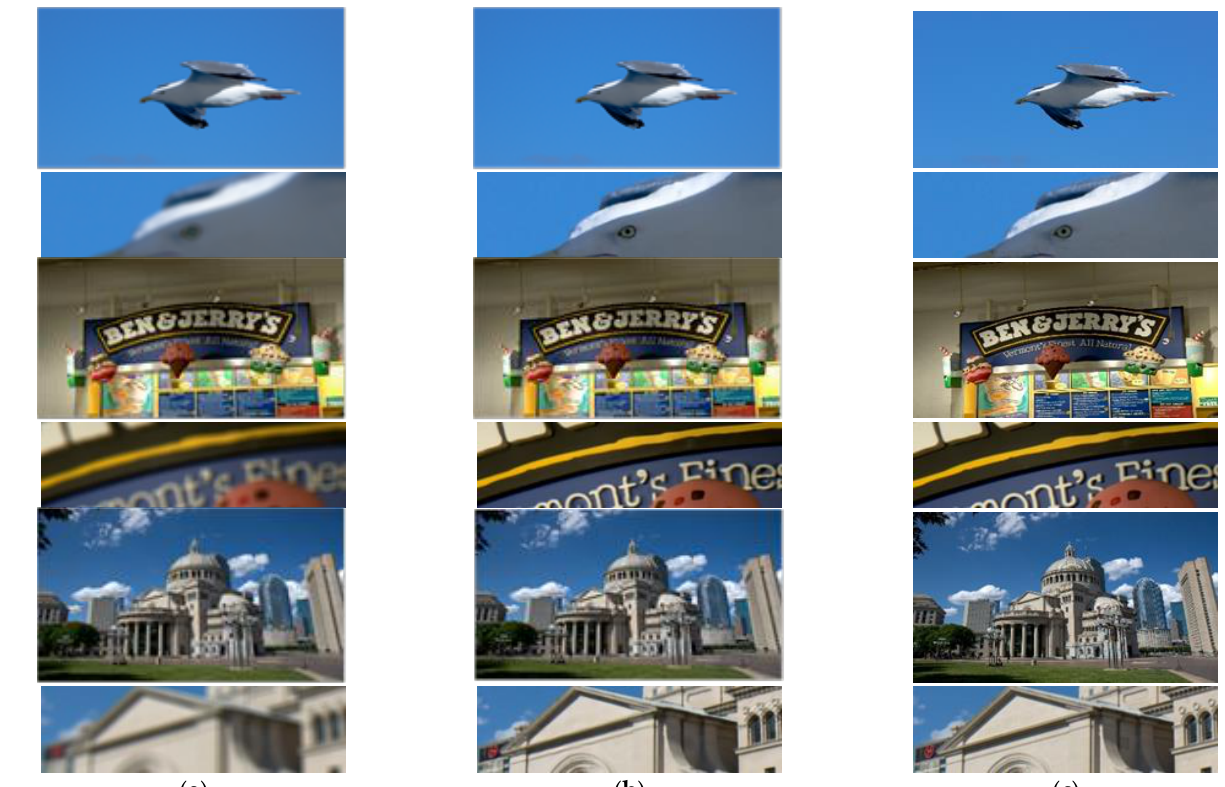
Figure 5. RRG-GAN restoring results based on CODE V simulation dataset: ( a ) Blurry images simulated by CODE V; ( b ) The restoring results; ( c ) The ground-truth.